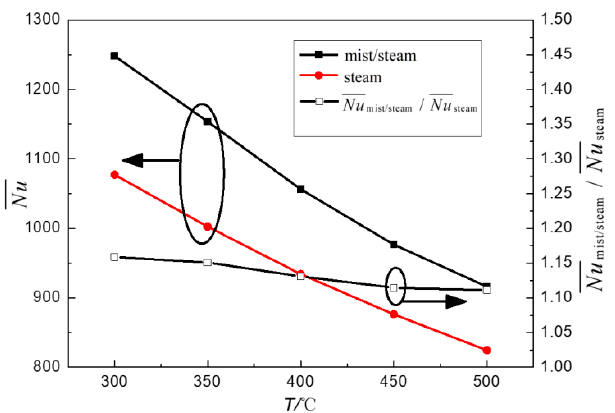
Figure 6. Variation in the average Nusselt number of the ribbed surface of mist / steam cooling and steam cooling channels with the coolant temperature.